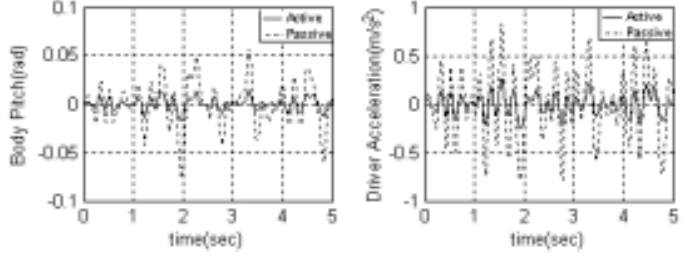
Fig. 7. Comparison between passive and active systems for the body pitch and driver